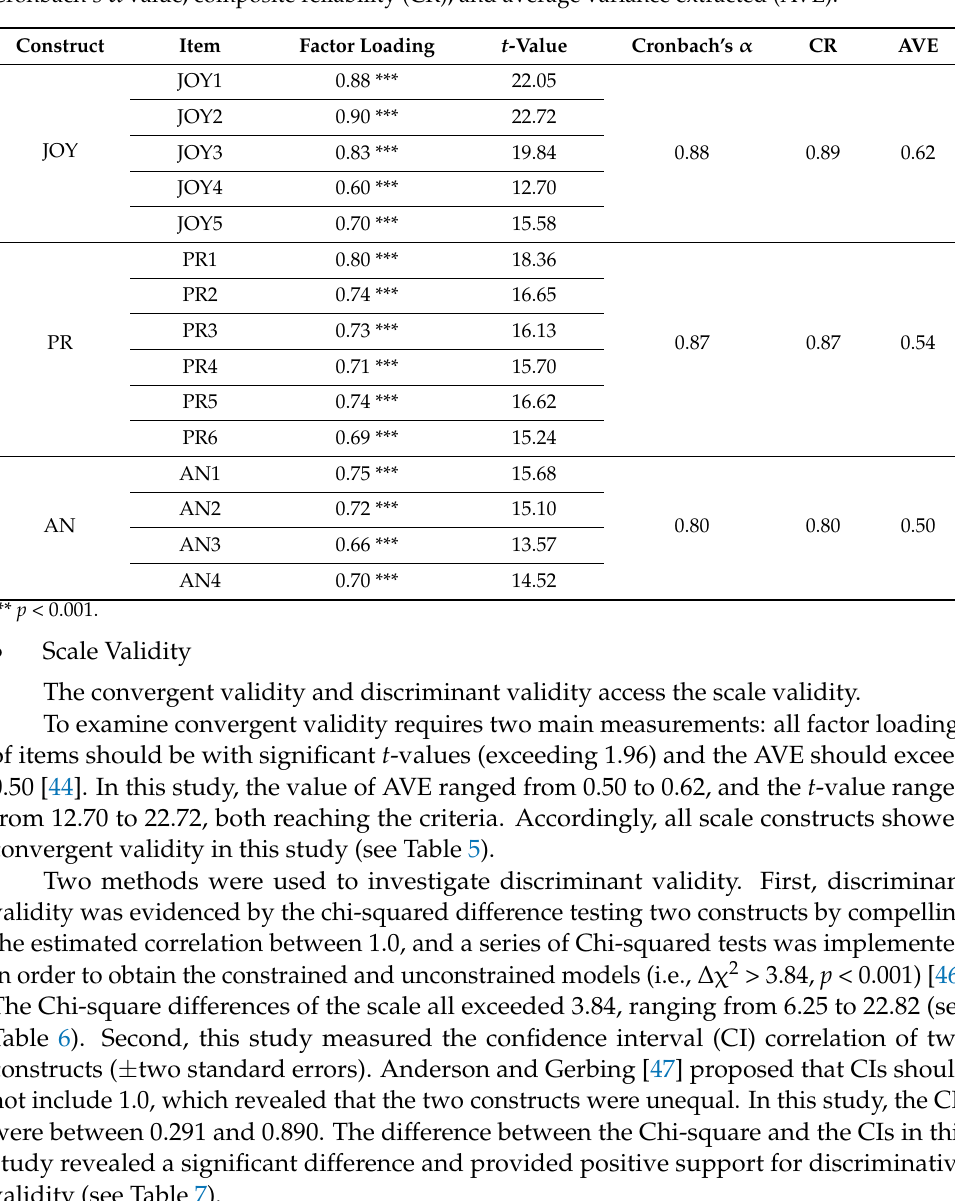
Table 5. Measurement accuracy analysis statistics (the first wave): factor loading and its t -value, Cronbach’s α value, composite reliability (CR), and average variance extracted (AVE).